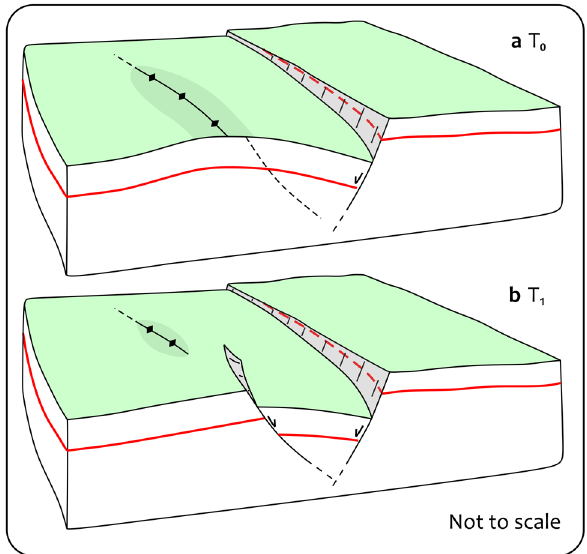
Figure 5. Off-fault deformation development. Conceptual model of the long wavelength hangingwall deformation. ( a ) Hangingwall bending increases where the fault displacement is higher. ( b ) Rupture of the hangingwall following its forward migration, and development of an antithetic